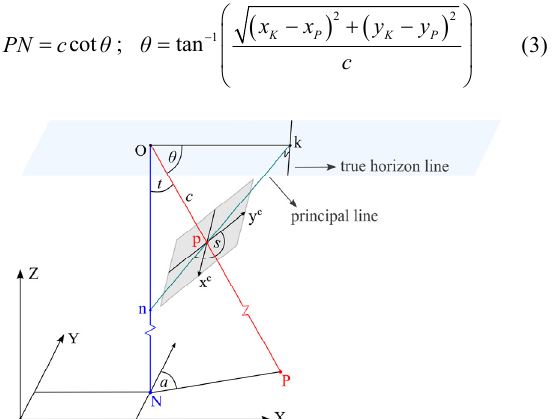
Figure 2. Tilt, swing and azimuth in an oblique aerial image